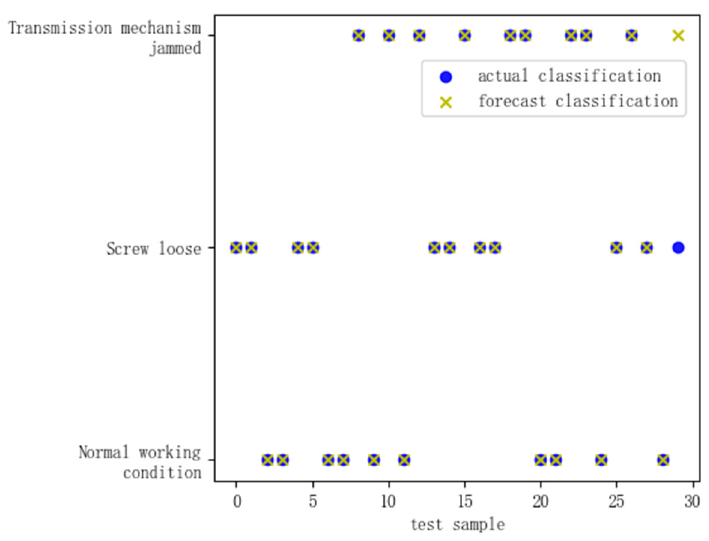
Figure 9. Recognition results of AdaBoost − SVM.